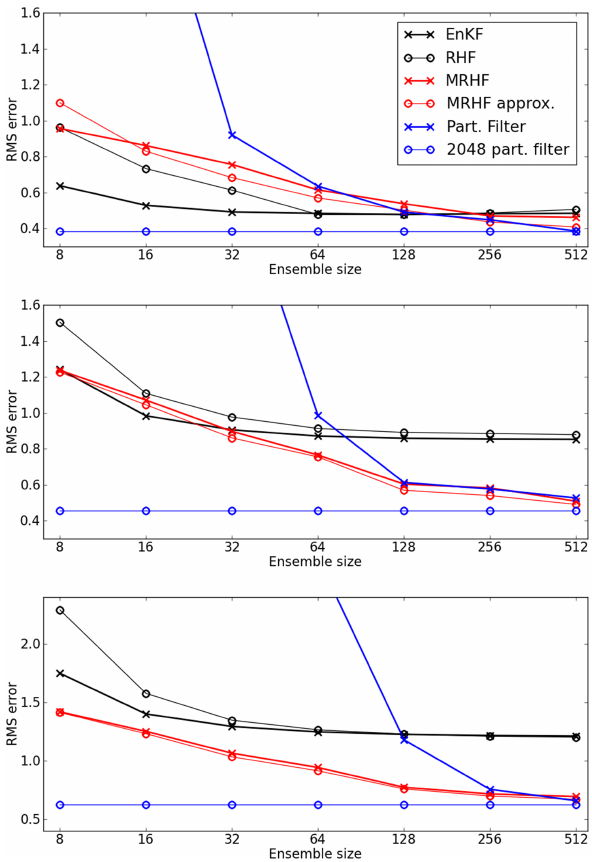
Figure 8. Time-averaged analysis root mean square error (RMSE) for the EnKF (thick black line with crosses), the RHF (thin black line with open circles), the SIR particle filter (thick blue line with crosses), the full MRHF (thick red line with crosses), and the mean- field approximated MRHF (thin red line with open circles); for ex- periments on the fully observed Lorenz 63 with observation time intervals 1t = 0.10 (upper panel), 1t = 0.25 (center panel), and 1t = 0.50 (bottom panel). The thin blue line with open circles rep- resents the time-averaged analysis RMSE for the SIR particle filter with 2048 particles, which can be considered as a target score.